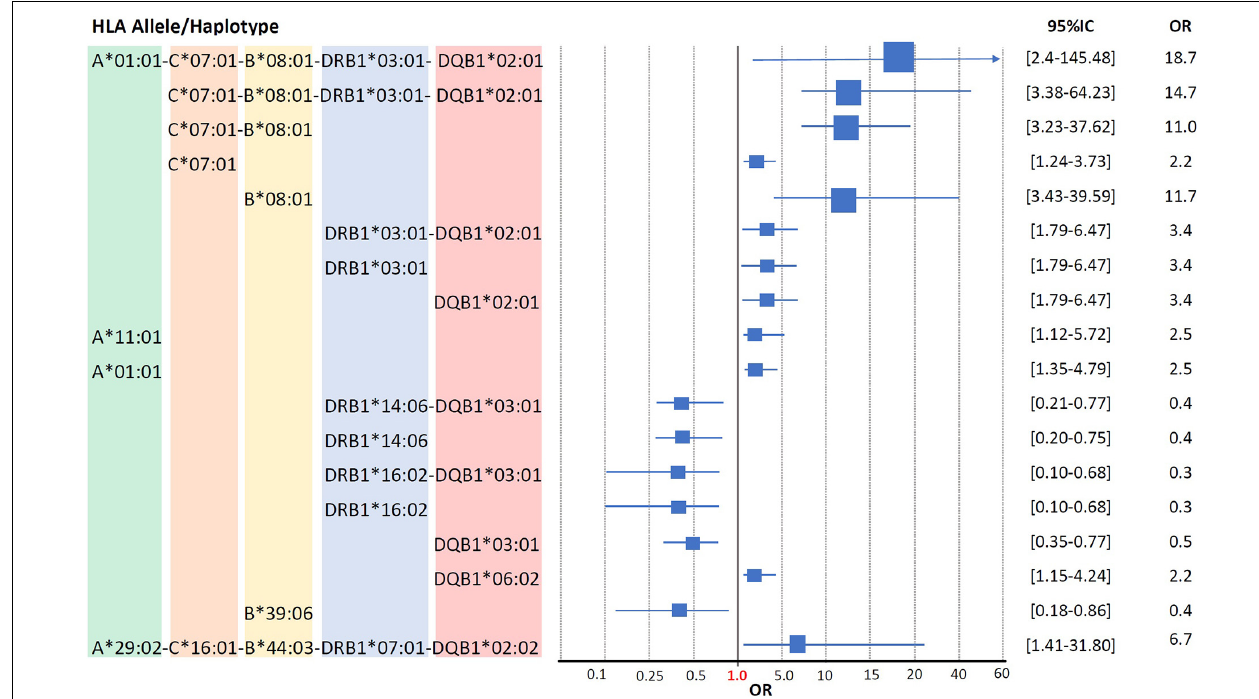
FIGURE 4 | Human leukocyte antigen susceptibility and protection alleles and haplotypes in Mestizo Mexican SLE patients. The alleles and haplotypes, which showed statistically significant differences between SLE patients and healthy individuals ( p < 0.05), are shown in the Forest plot. The Odds ratios and 95% interval confidence are included in the graphic. Blue boxes are not at